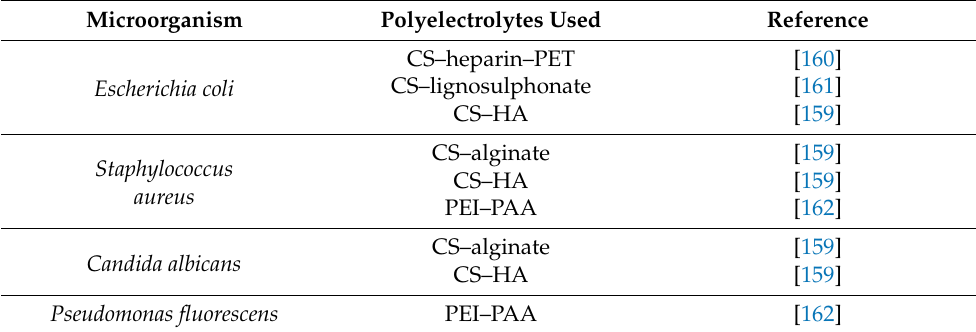
Table 2. Multilayers based on polyelectrolytes with antimicrobial activity. Microorganism Polyelectrolytes